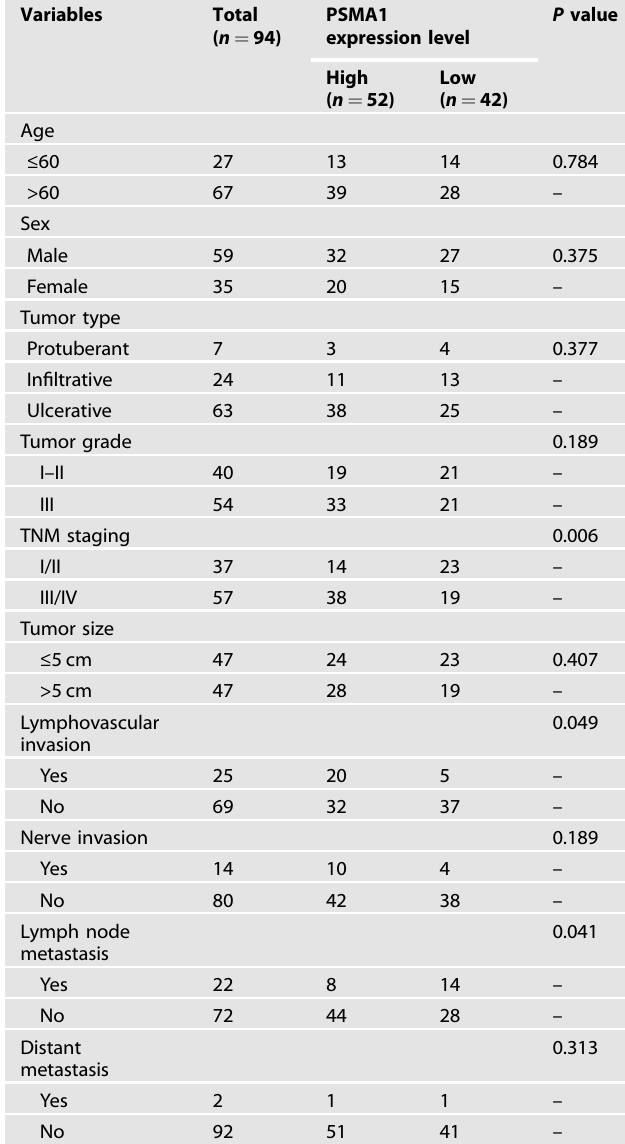
Table 1. Correlation between PSMA1 protein expression and clinicopathologic characteristics of GC.